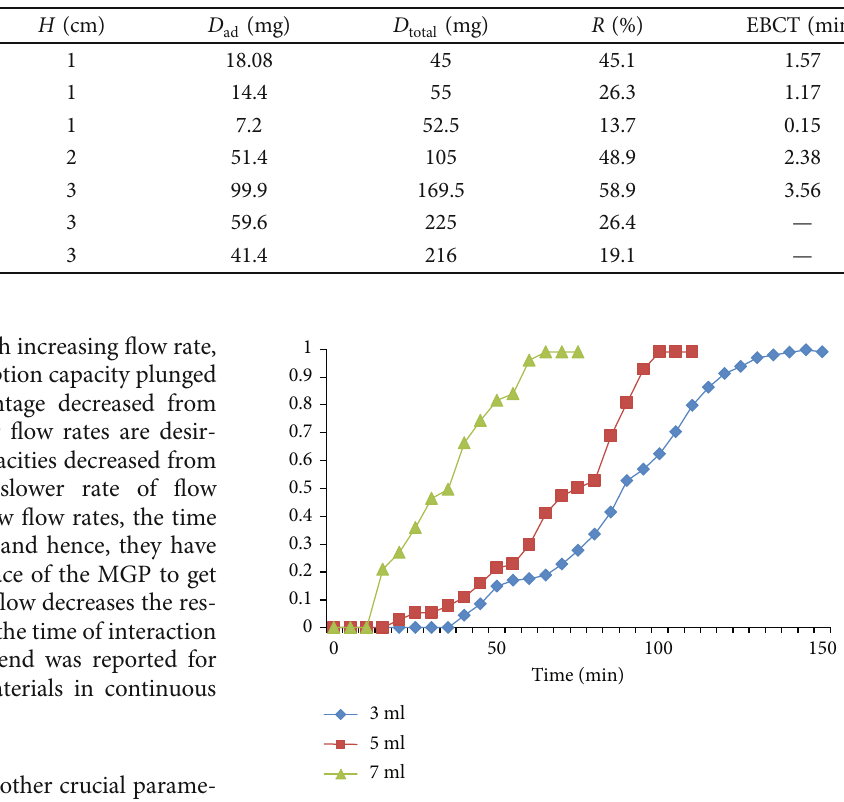
Figure 4: Optimization graph for pH for the removal of CV by MGP. Table 1: Continuous column parameters for the removal of CV by MGP.